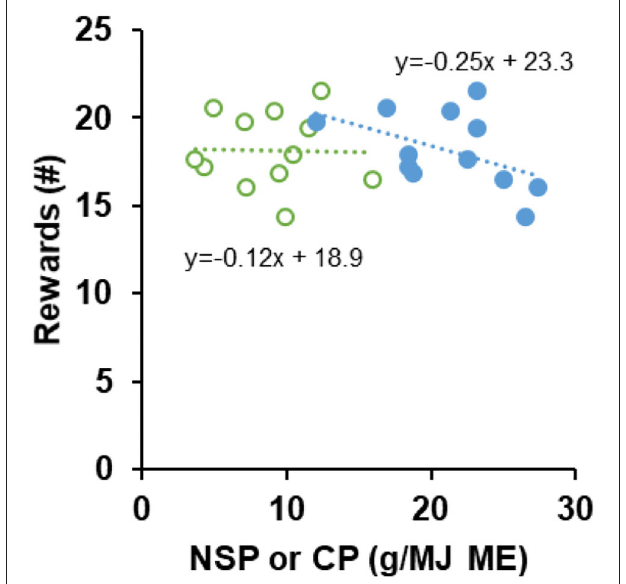
FIGURE 3 | Number of rewards obtained by lever pressing for kibbles. Cats ( n = 10 to 11) were adapted to dry extruded foods with differing levels of non-starch polysaccharides (NSP, green open markers) and crude protein (CP, blue filled markers) and tested for motivation around 5h after their morning meal. Slopes of regression lines were different from 0 for protein level ( P = 0.014) but not for NSP level ( P =